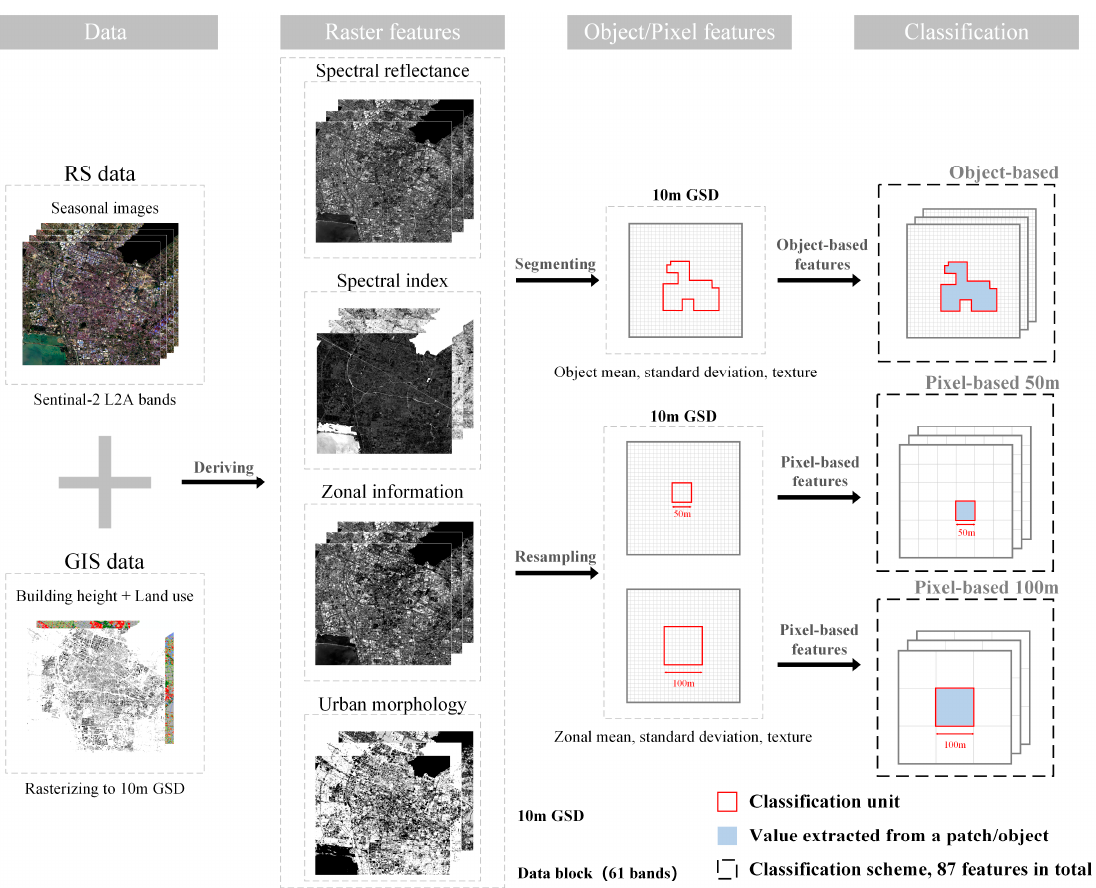
Figure 3. The schematic workflow of LCZ mapping and comparison schemes.